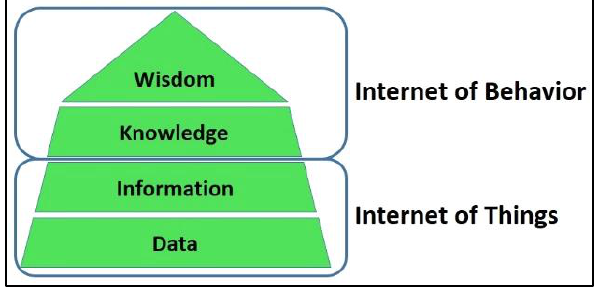
Figure 1. The DIKW